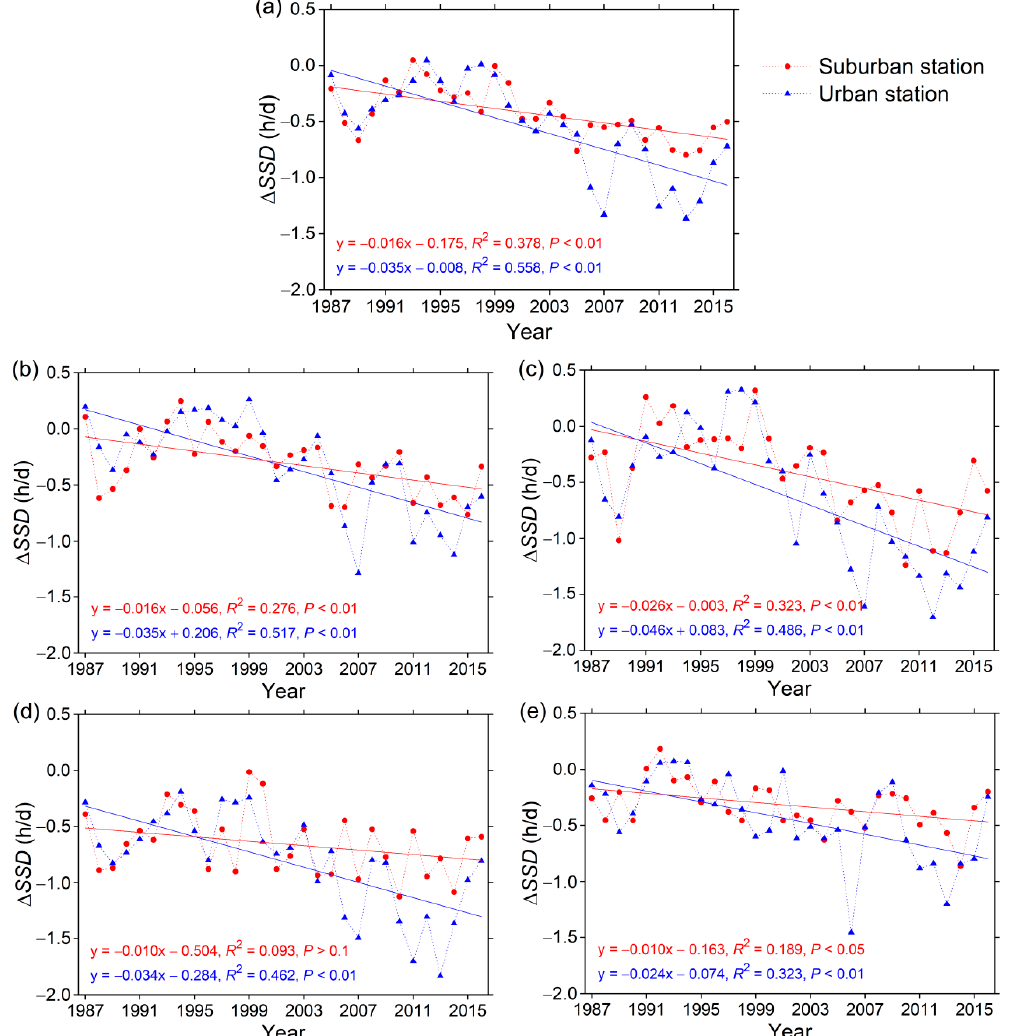
Figure 4. Urbanization effects on ( a ) annual, ( b ) spring, ( c ) summer, ( d ) autumn, and ( e ) winter variations of sunshine duration ( ∆ SSD ) at suburban and urban stations from 1987 to 2016.